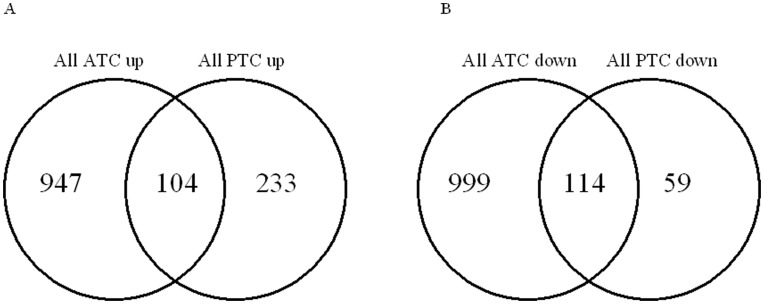
Venn diagrams of the significantly A) upregulated genes in all ATC and all PTC and B) downregulated genes in all ATC and all PTC.